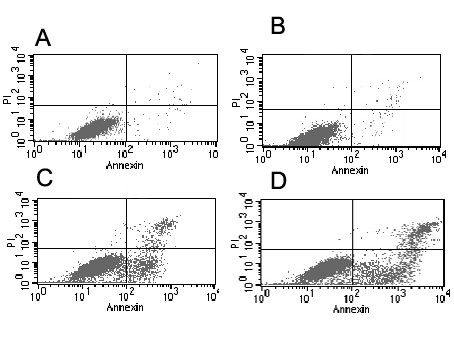
Gefitinib-induced apoptosis in H-157 cells before and after irradiation. Attached cells were exposed to 6 Gy irradiation and then treated with 100 nmol/L gefitnib. After additional 48-hour incubation in medium containing the drugs, the cells were harvested. The apoptotic index (AI) was measured using flow cytometry. (A) Control groups (AI: 1.36 ± 0.74%). (B) Apoptotic values after treatment with 100 nmol/L gefitinib alone (AI:3.58 ± 0.61%).(C) Radiation- induced apoptosis induction (14.26 ± 2.97%% of total cells) in H-157 cells.(D) Radiation combined with gefitinib induced apoptosis induction (23.58 ± 3.61% of total cells). Apoptotic values were normalized by subtracting control values; the normalized apoptotic values were used for statistical analyses. Experiments were done in triplicate. Combined drug treatments were shown to enhance radiation-induced apoptosis in H-157 cells (t = 19.91, P < 0.01), but no synergistic manner when compared with drug alone without radiation (t = 2.569, P > 0.05).